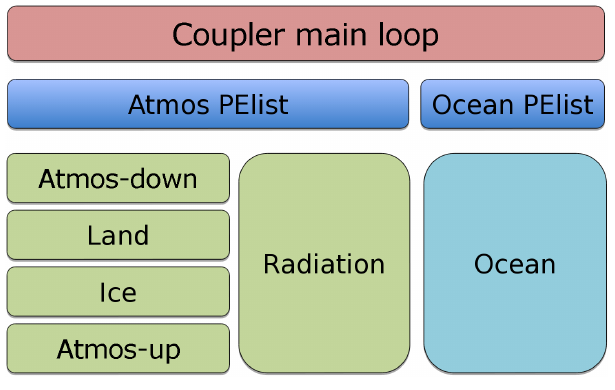
Figure 4. Concurrent radiation architecture. See Fig. 3 for compar- ison, and explanation of